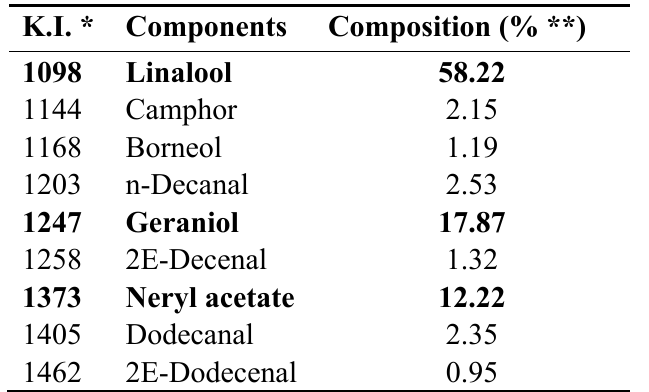
Table 1. Chemical composition of the essential oil from C. sativum